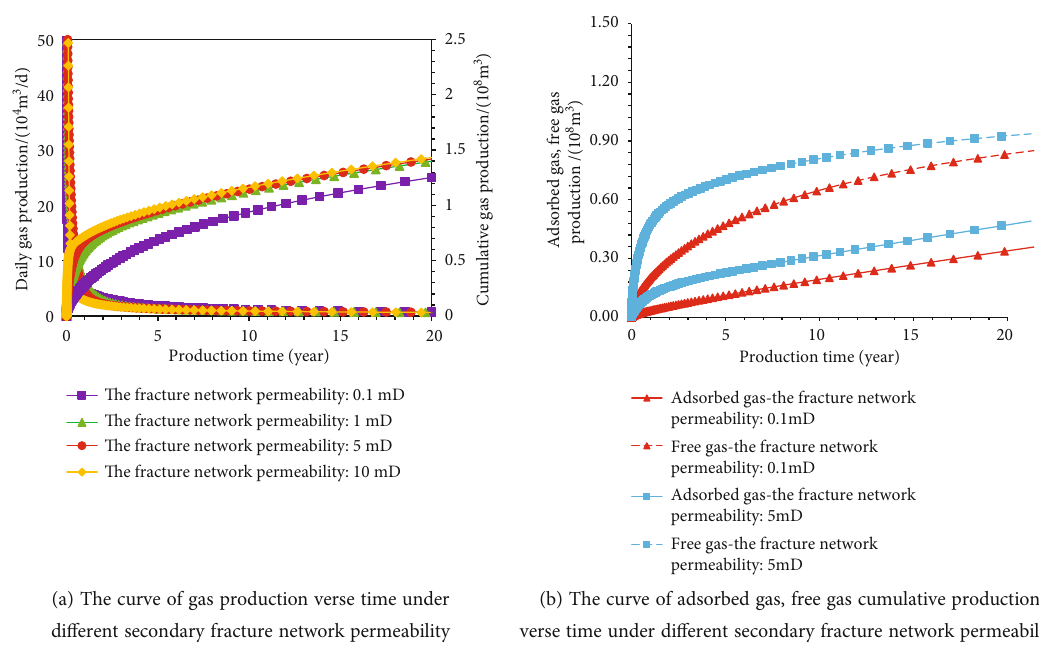
Figure 10: E ff ect of secondary fracture network permeability on shale gas